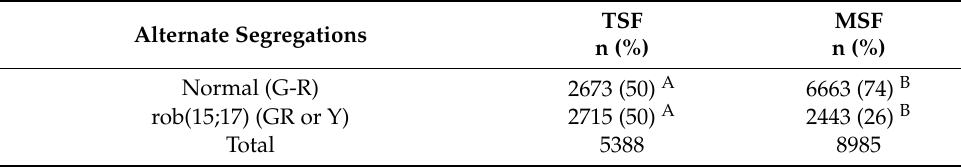
Table 4. Alternate sperm segregation of rob(15;17) carrier by chi-square test. Alternate